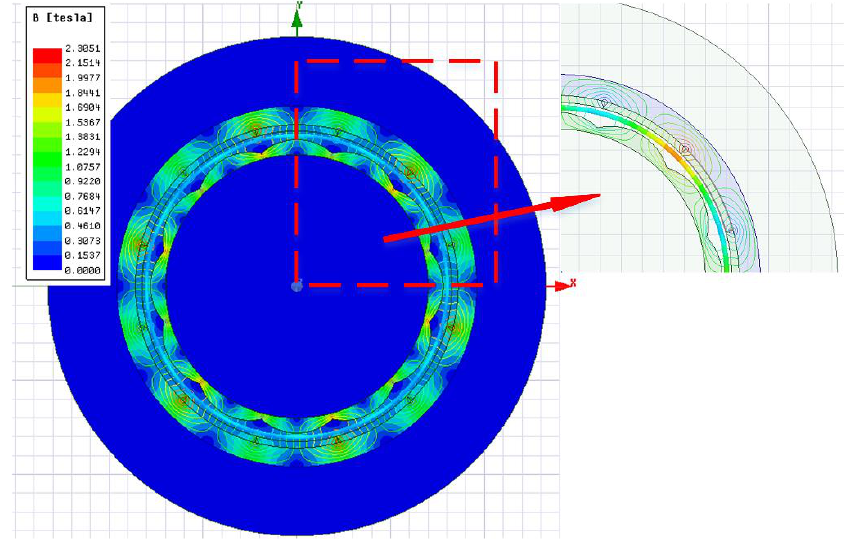
Figure 4. Magnetic map and magnetic line distribution diagram of the motor under FEA.